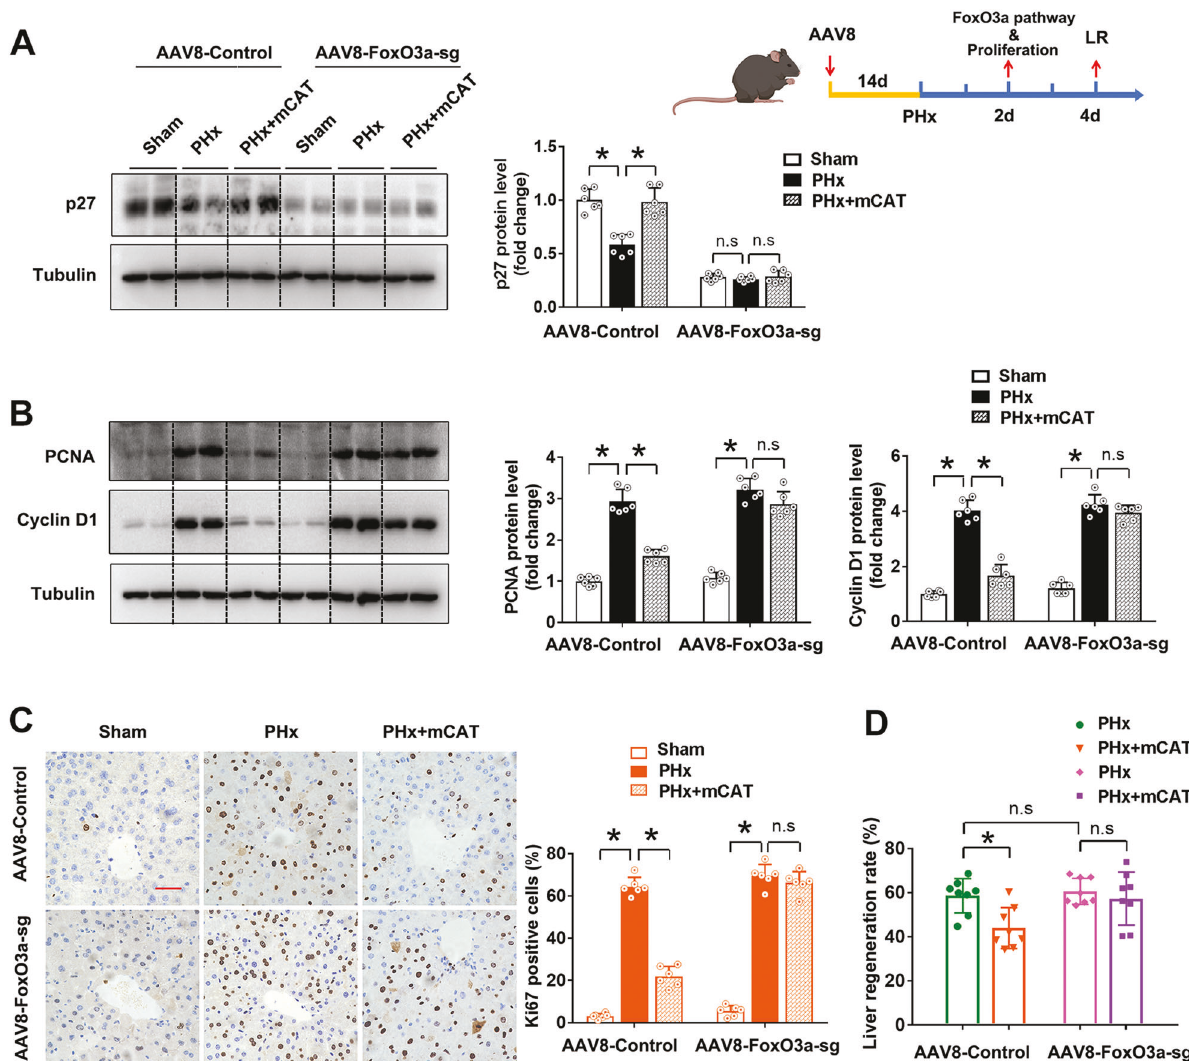
Fig. 6 FoxO3a knockdown ameliorated the LR inhibition by overexpression of mCAT after PHx in mice. The C57 mice were injected with a recombinant AAV8 carrying mitochondria-targeted CAT (mCAT) gene and/or a recombinant AAV8 carrying the sgRNA sequence for FoxO3a to overexpress mCAT and/or knockdown FoxO3a speci fi cally in the liver. The LR were determined on the 2nd day after the mice were subjected to PHx. A Schematic representation of the experimental procedure and western blot analysis and quanti fi cation of p27 protein level (three independent experiments). B Western blot analysis and quanti fi cation of PCNA and Cyclin D1 (three independent experiments). C Immunohistochemistry staining and quanti fi cation of Ki67, bar = 50 µm, n = 6. D LR rate, n = 8. Data are shown as means ± SEM. Signi fi cance was designated with * P <